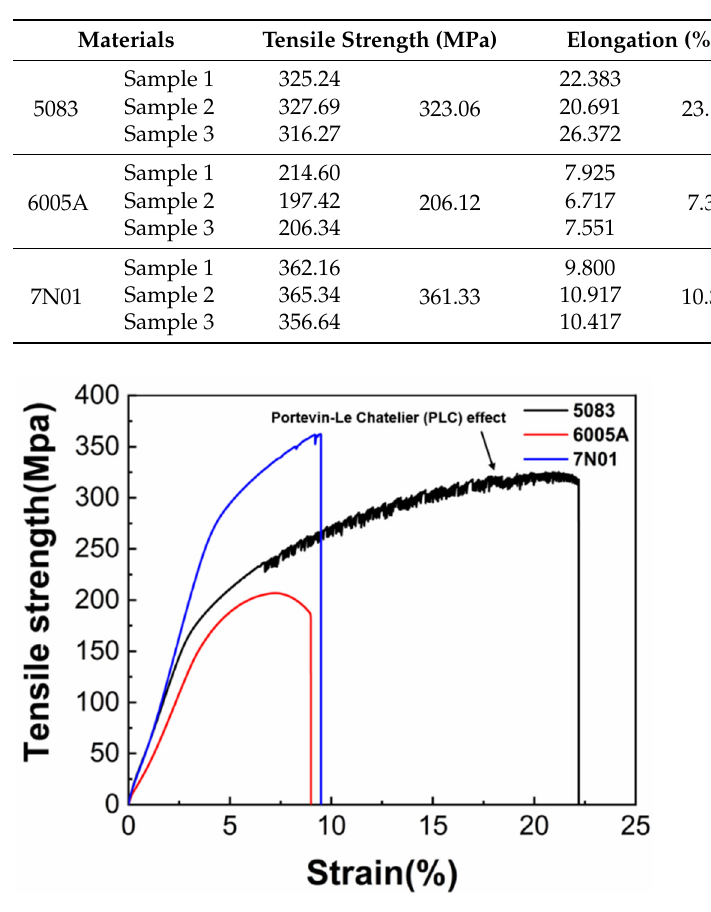
Table 4. Detailed data of tensile test.